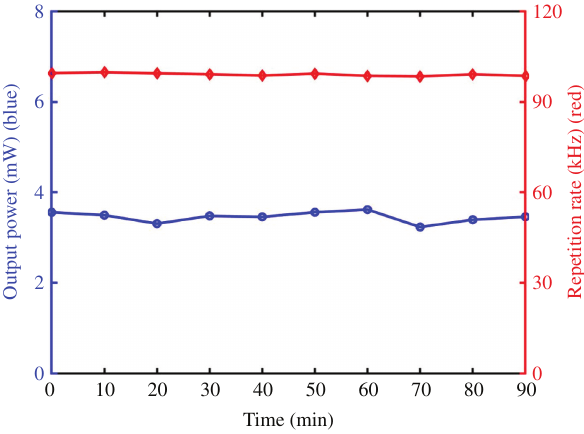
Figure 9: Measurements of output power and pulse repetition rate for long-term